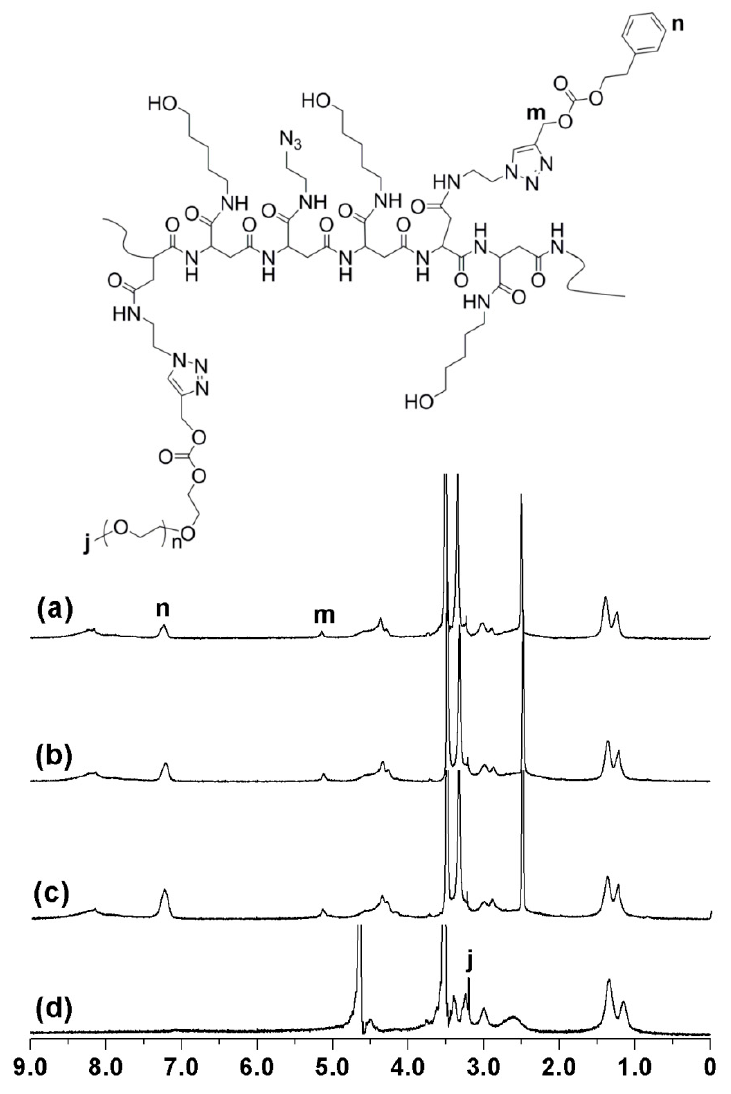
Figure 3. 1 H NMR spectra of ( a ) mPEG-PAAHP-2, ( b ) mPEG-PAAHP-3 and ( c ) mPEG-PAAHP-5 in DMSO-d 6 , and ( d ) mPEG-PAAHP-3 in D 2 O at 25 °C.